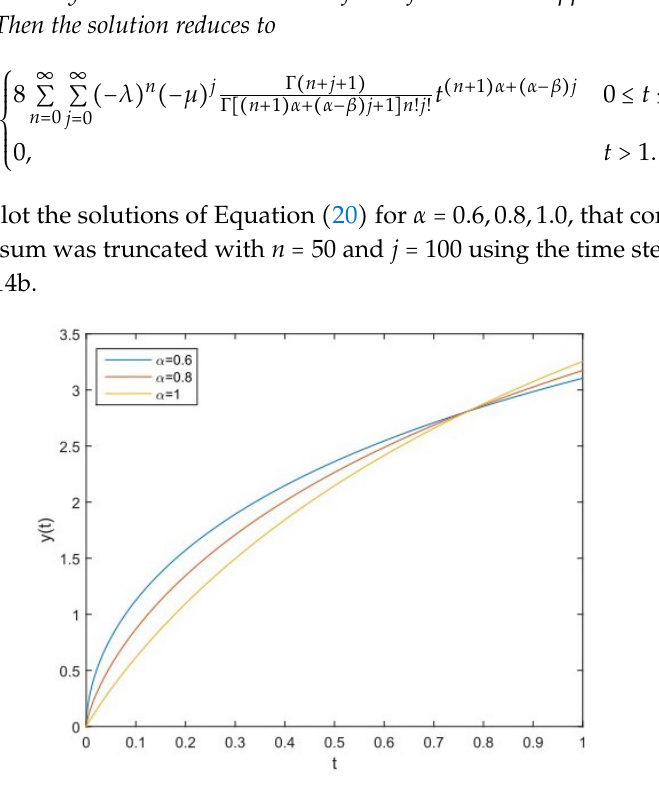
Figure 1. Dynamics of a sphere in an incompressible viscous fluid (Fixed β ) .